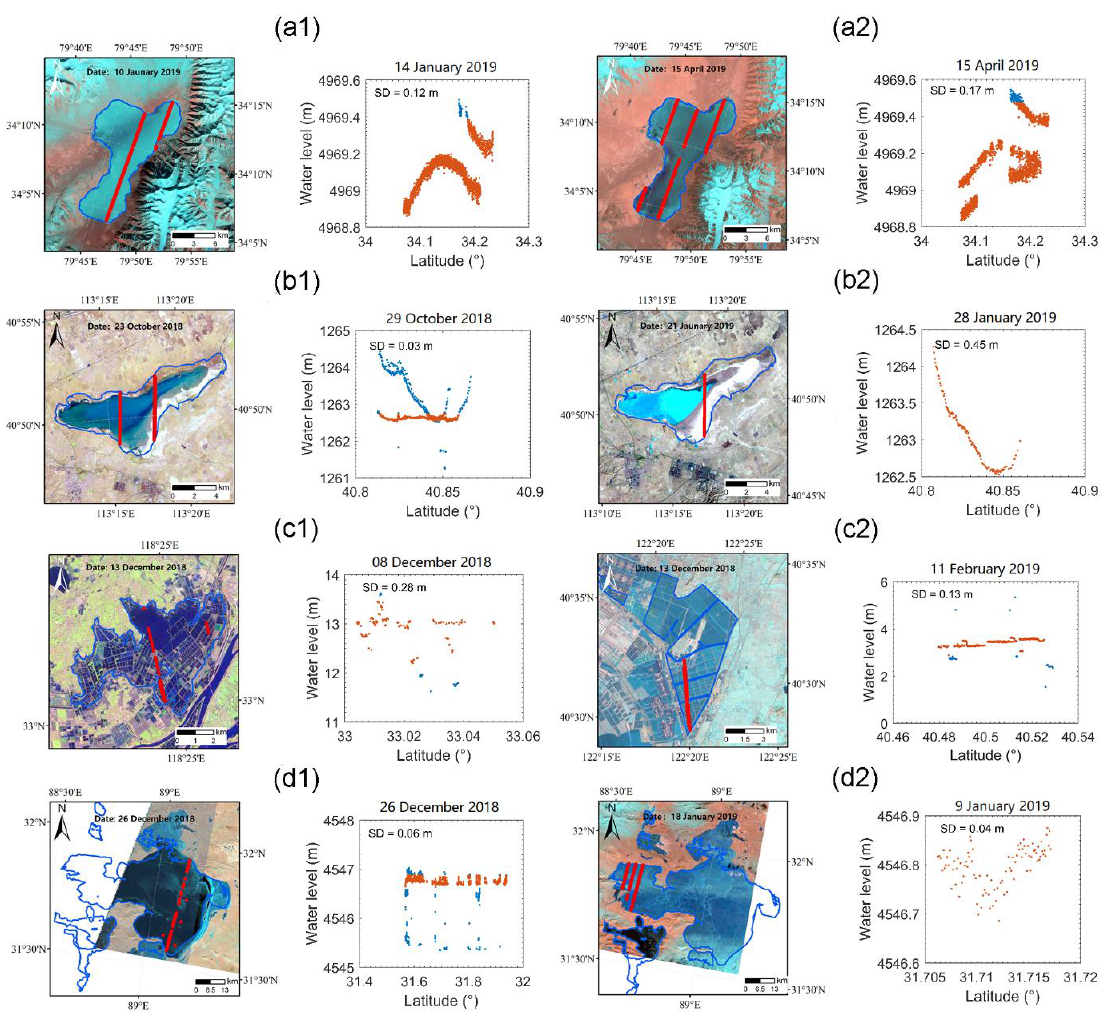
Figure 9. Examples of water surface profile derived from the ICESat-2 data. In the eight insets, the left panel shows the location of footprints (red dots), and the right panel shows the LSH profile. In the left panel, Sentinel-2 images (acquired around the observation time of the ICESat-2) are used as background map, downloaded from the United States Geological Survey (https://glovis.usgs.gov/). In the right panel, the blue dots are outliers detected by the IQR method, and the orange dots are the remaining observations. ( a1 ) and ( a2 ) show the LSH profile of an alpine lake named Ze Co in the Tibetan plateau. ( b1 ) and ( b2 ) show the profile of a shallow lake named Huangqihai Lake in Inner Mongolia. ( c1 ) shows the profile of a partitioned lake named Dou Lake nearby the Yangtze River. ( c2 ) shows another partitioned lake in Bohai Bay. ( d1 ) and ( d2 ) show the profile of a seasonal frozen lake named Selin Co, and it is not completely frozen in ( d1 ) and completely frozen in ( d2 ).